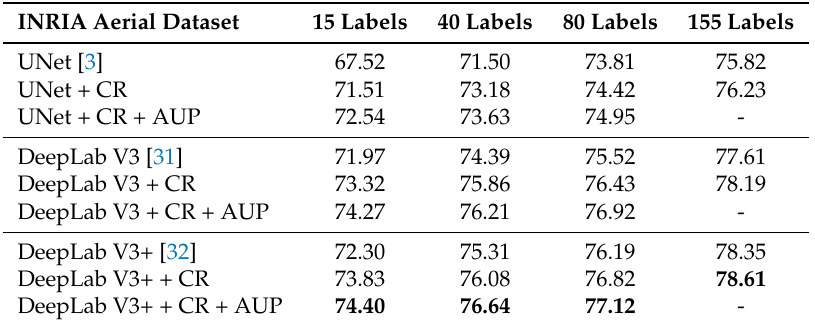
Table 2. Segmentation accuracy (mIoU, %) comparison of CR and AUP in our method on INRIA Aerial dataset when different network structures are